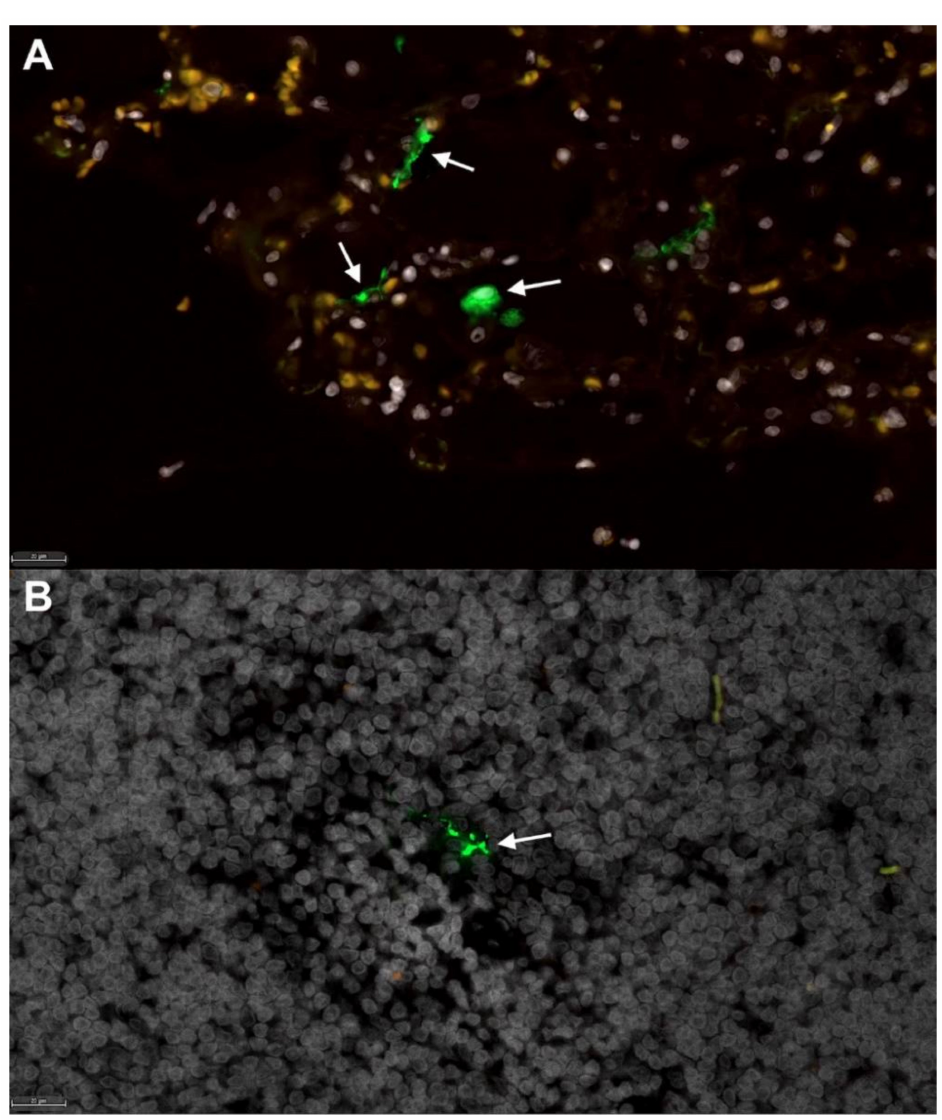
Figure 3. Fluorescent immunohistochemistry for SARS-CoV-2 nucleoprotein identifies mononuclear cells in tracheobronchial lymph nodes of intratracheally infected cats. Low numbers of SARS-CoV-2 positive cells (green, white arrows) are detected in ( A ) positive control tissue (lung) from an African Green Monkey infected with SARS-CoV-2 [50], and within ( B ) mononuclear cells in the TBLN of SARS-CoV-2-infected cats (green, white arrow). White, DAPI/nuclei; green, CoV-2. Magnification 40 × , scale bar = 20 µ